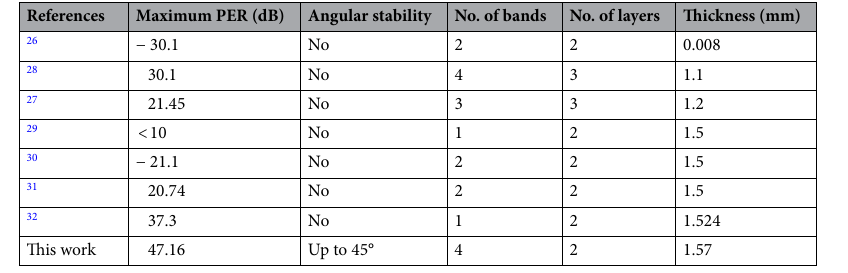
Table 1. Comparison of different CPS